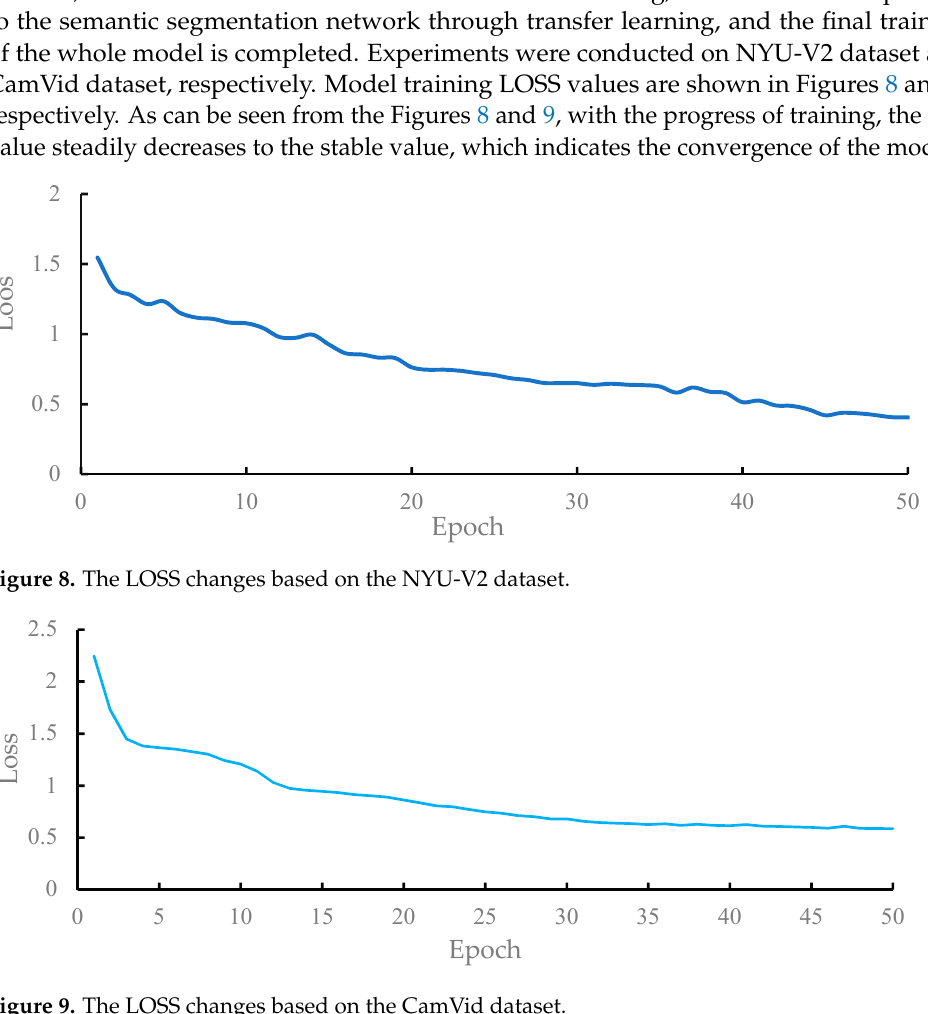
Figure 9. The LOSS changes based on the CamVid